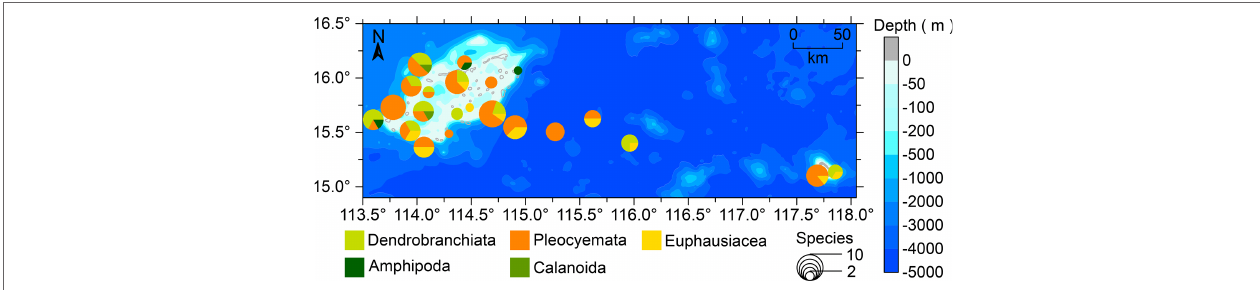
FIGURE 4 | The species composition and spatial distributions of marine crustacean larvae collected at the Zhongsha Islands, South China